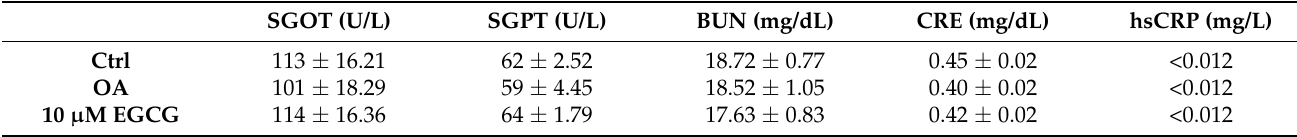
Table 1. The results of blood